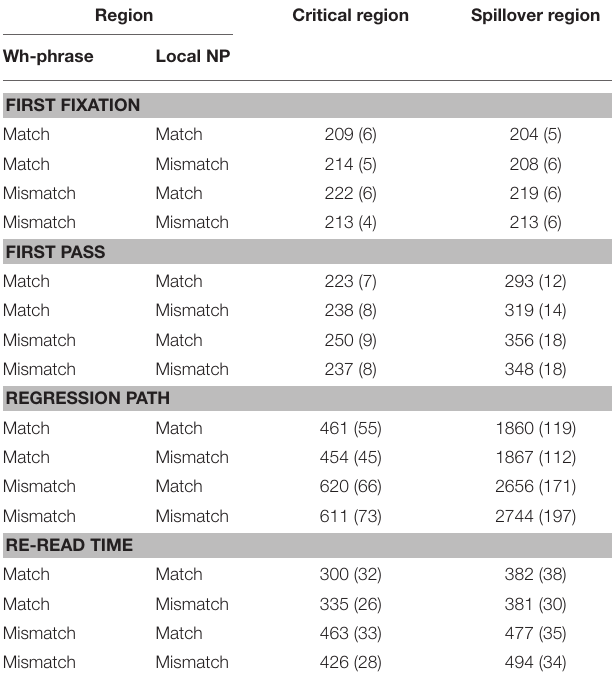
TABLE 3 | Means (and Standard Errors) for Experiment